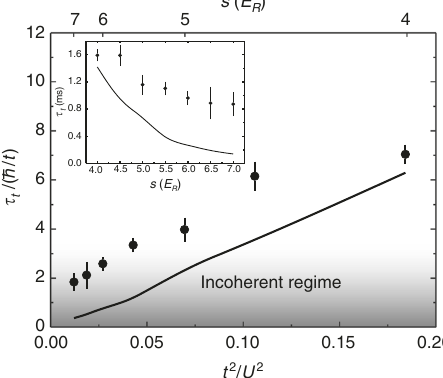
Fig. 5 Transport lifetime normalized to the tunneling time at varied interaction strength. The inset shows the measured τ t determined from fi ts to data such as those shown in Fig. 2b. For the FGR weak scattering calculation, ~ T and ~ μ are fi xed to the values for these parameters averaged across the data set. The vertical error bars show the uncertainty in the fi t used to determine τ